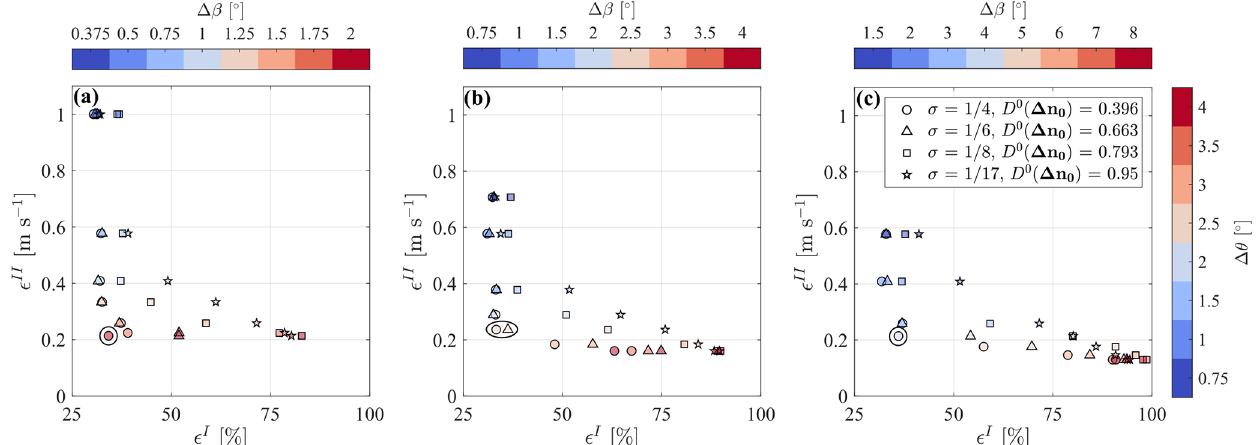
Figure 11. Pareto front for the design of the optimal lidar scan for the LES data set for different (cid:49)θ/(cid:49)β combinations. (a) (cid:49)β/(cid:49)θ = 0 . 5. (b) (cid:49)β/(cid:49)θ = 1. (c) (cid:49)β/(cid:49)θ = 2. The circle indicates the selected optimal configurations.